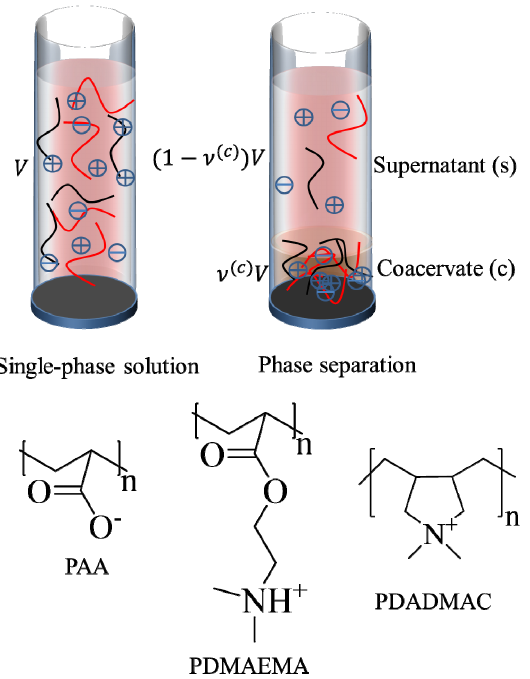
Figure 1. Polyelectrolyte complexation in an aqueous mixture of oppositely charged polyelectrolytes, with their counterions and salt ions. Polycations, polyanions, and salt ions are represented with black lines, red lines, and symbols, respectively. A single-phase solution is observed when phase separation does not occur (top left) and distinct supernatant and dense phases are formed after phase separation (top right). A precipitate or a cloudy phase may also form instead of the coacervate phase shown in the picture. (cid:2021) ((cid:3030)) and V are the volume fraction of dense phase and the total volume of the solution, respectively. Polyelectrolytes discussed in the paper are also shown in the